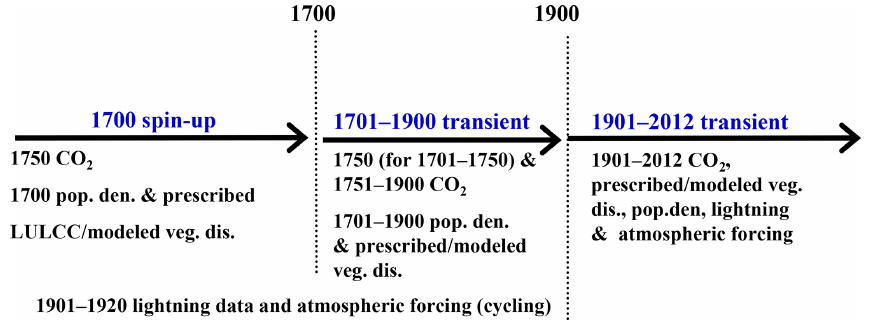
Figure 1. FireMIP experiment design. Note that CTEM and MC2 start at 1861 and 1901 and spin-up using 1861 and 1901 CO 2 , population density, and prescribed/modeled vegetation distribution,